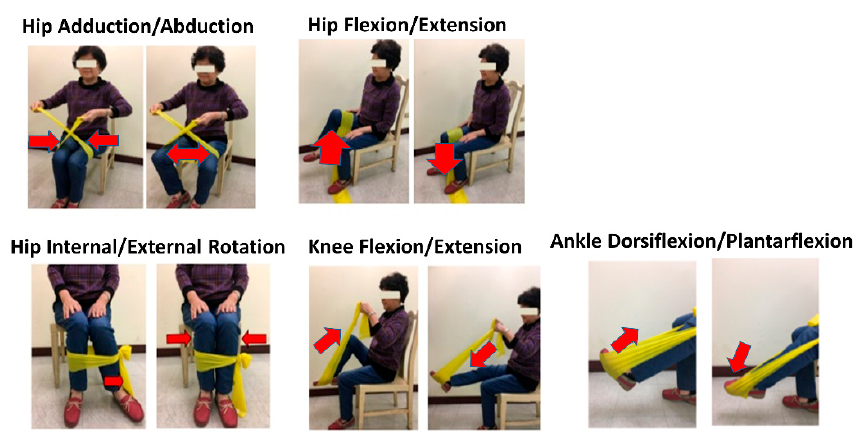
Figure 1. Dynamic exercise programs with elastic bands.